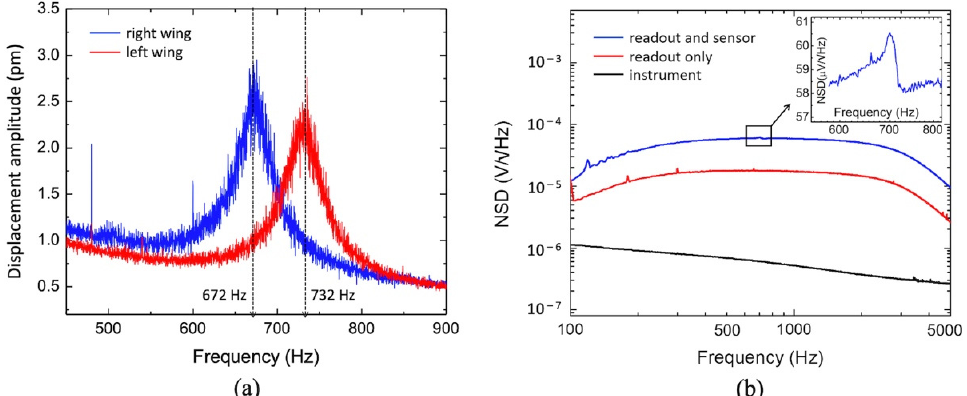
Figure 6. Mechanical and electrical noise: ( a ) Measured intrinsic bending vibration of the sensor in absence of any sound stimulus. ( b ) Measured electrical noise spectral density of the instrument, readout electronics with a 22 pF fixed capacitor connected to the input of the charge amplifier (readout only) and readout electronics with the MEMS sensor connected. The inset shows a zoom in of the area highlighted by the square, where the vertical scale is linear for better view of the effect. Note that the intrinsic displacement amplitude is on the order of units of picometers, and the two resonances are clearly shown. There is a 14 Hz blue shift on both resonant peaks that is most likely due to the superimposition of the 1/f noise on the sensor response in addition to stress impinged on the sensor by the mount. At resonance, for typical MEMS